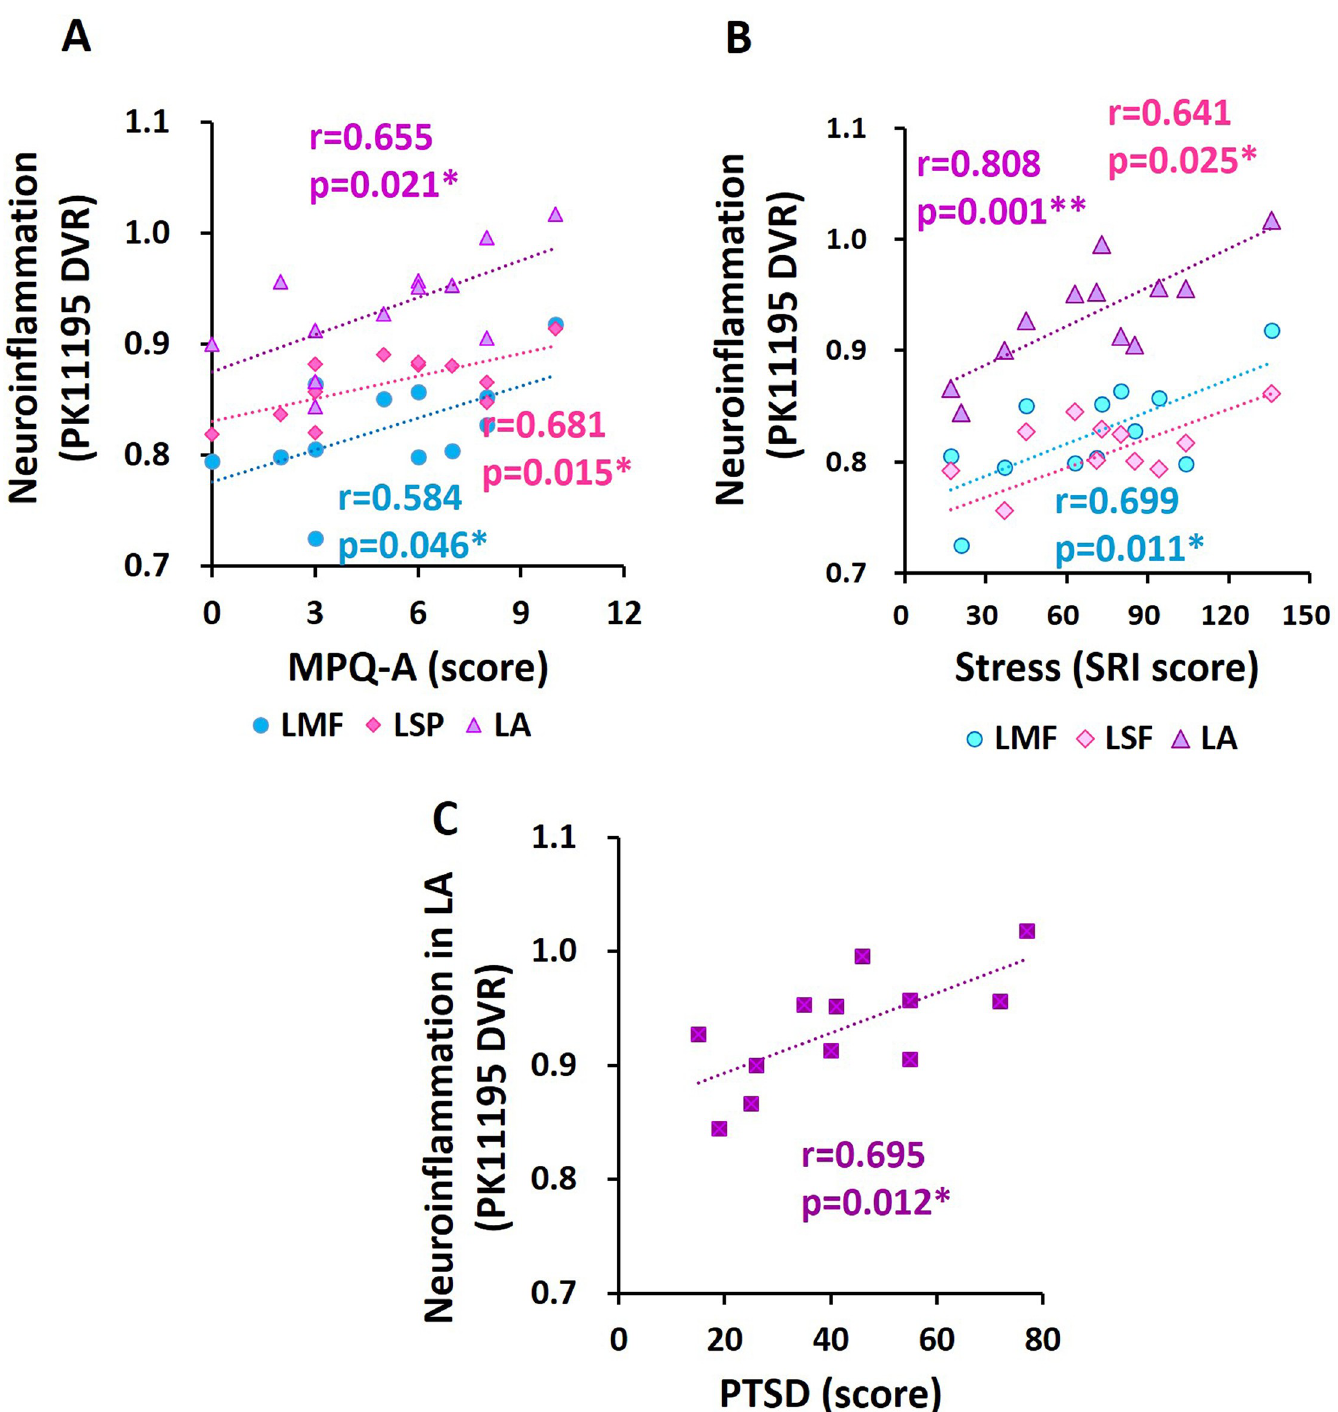
Fig 4. Correlations between affective pain, stress and PTSD and neuroinflammation ([ 11 C]-(R)-PK11195 DVR) in FM. (A-C) LMF: left medial frontal, LSF: left superior frontal, LSP: left superior parietal, LA: left amygdala. MPQ-A: McGill pain Questionnaire-Affective, SRI: Stress Response Inventory, PTSD: posttraumatic stress disorder. � p < 0.05, �� p <